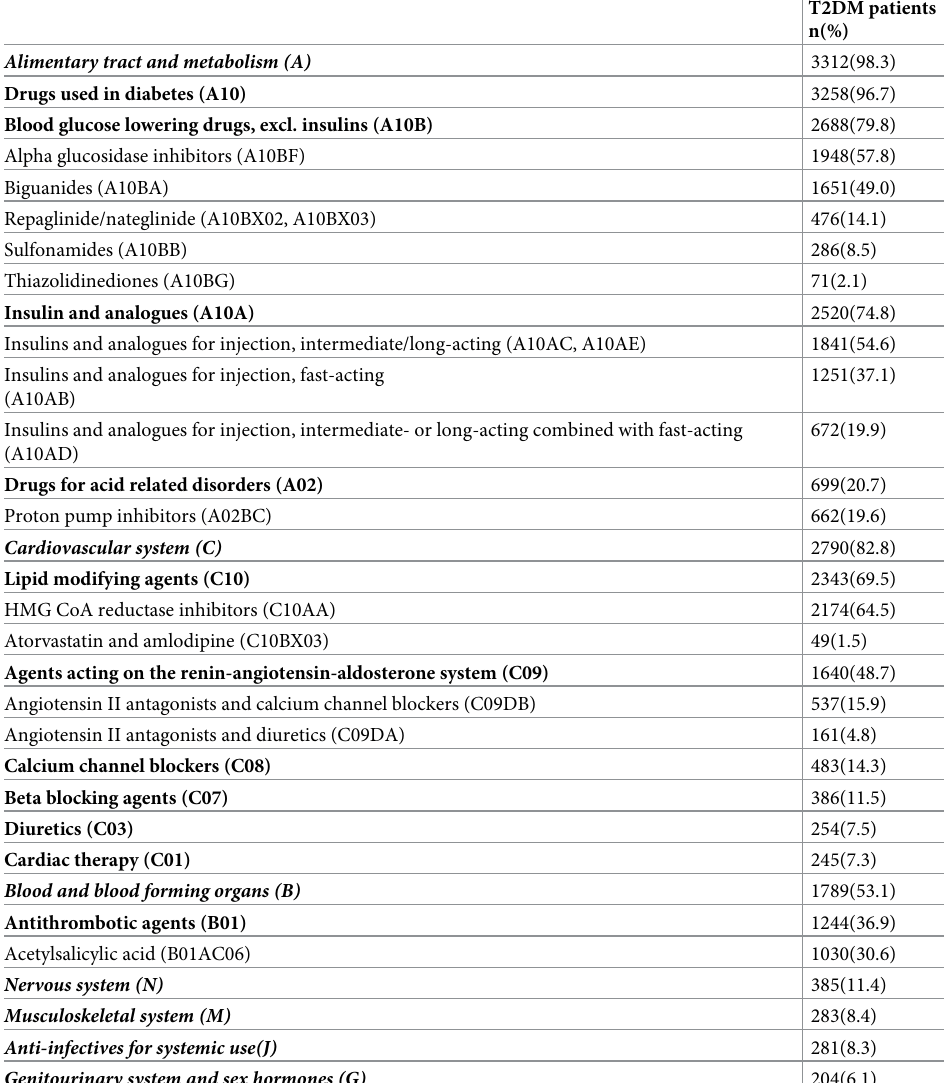
Table 1. Most commonly prescribed medicines in our study. Classification of medicines (based on ATC